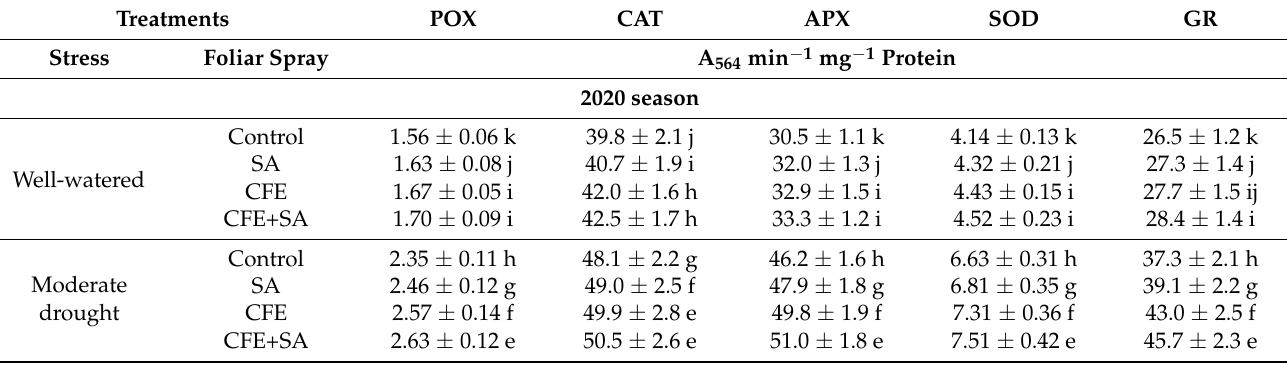
Table 7. Influence of foliar nourishment with clove fruit extract (CFE) and salicylic acid (SA) on peroxidase (POX), catalase (CAT), ascorbate peroxidase (APX), superoxide dismutase (SOD), and glutathione reductase (GR) activities of potato plants grown under three irrigation regimes in two